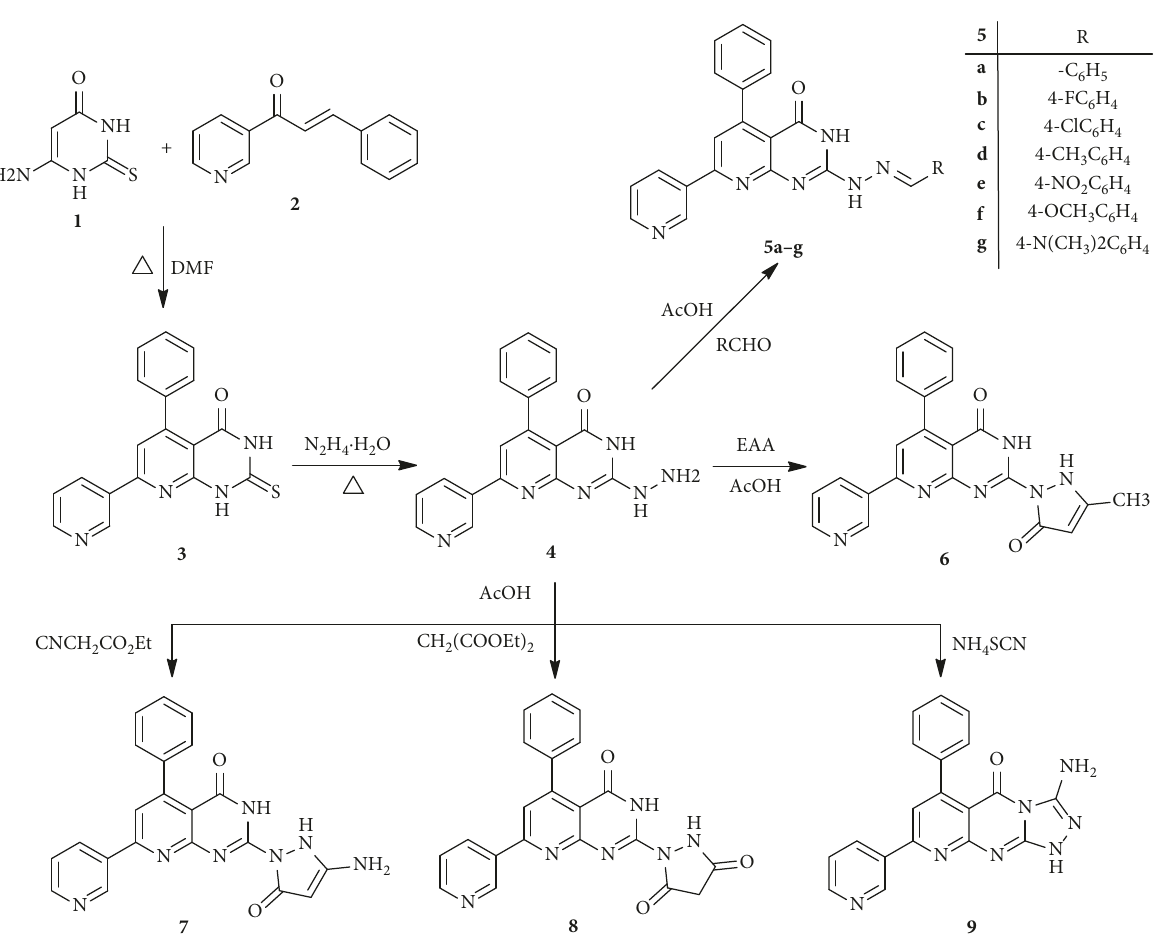
Scheme 1: Synthetic pathway for pyridopyrimidines ( 3 – 9